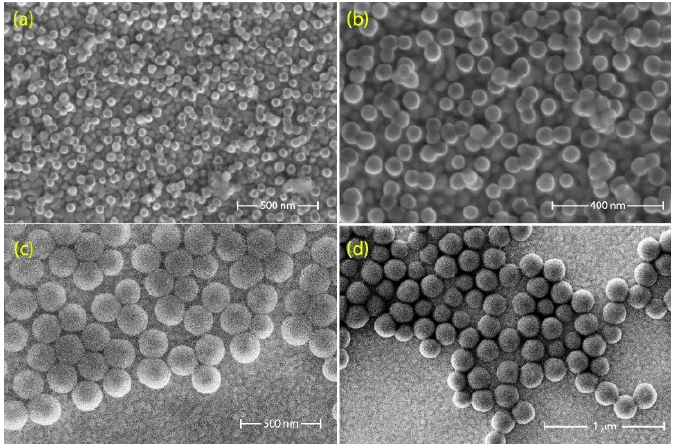
Figure 7. SEM micrographs of the 50 nm size nanoparticles ( a , b ) and 200 nm size SiO 2 immobilized over Au wafers ( c , d ).